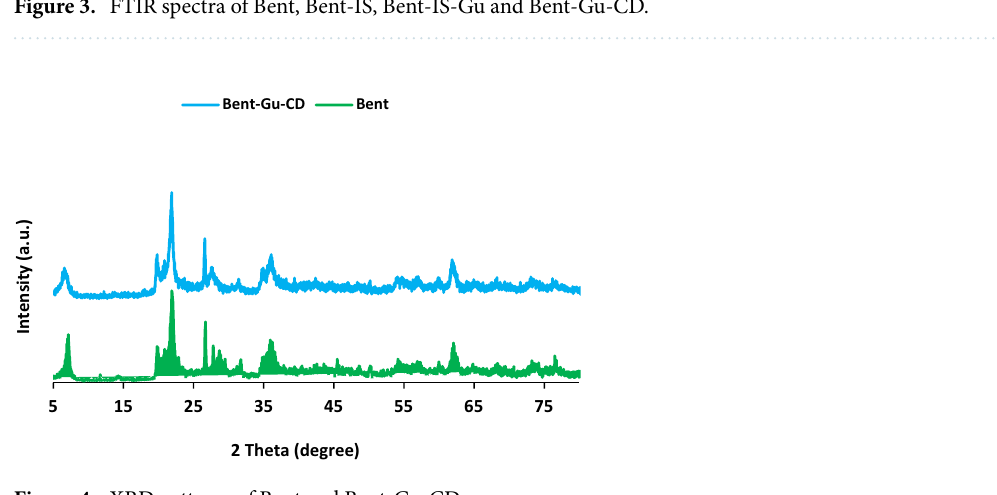
Figure 4. XRD patterns of Bent and